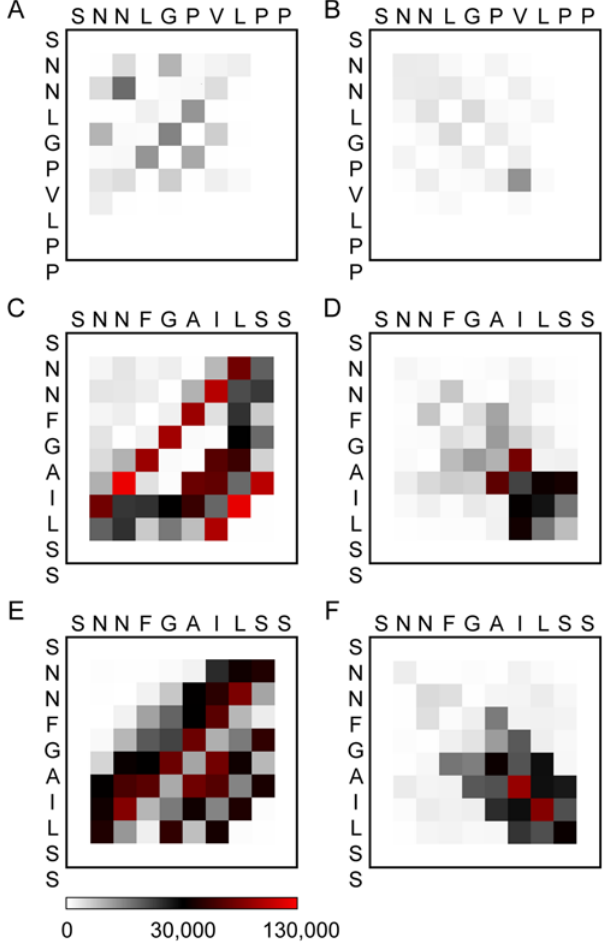
Figure 4. b -bridge occurrence contact map. (A) and (B), (C) and (D), and (E) and (F) count rIAPP, hIAPP and hIAPP/lipid, respectively. Left and right panels count only antiparallel and parallel b -bridges, respectively. The contact map is colored by the occurrences of residue pairs which make inter-strand b -bridge. Simulation data from the last 80 ns are